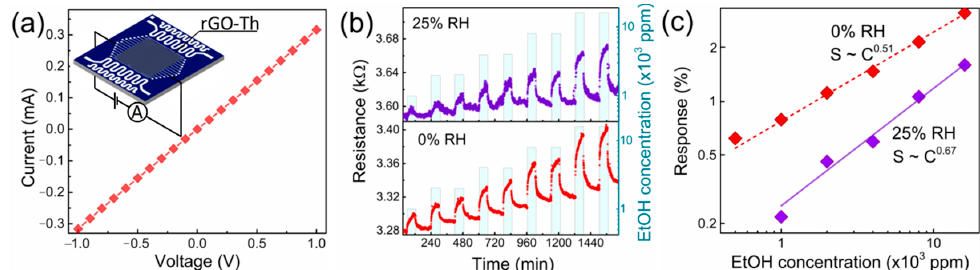
Figure 6. The chemiresistive performance of rGO–Th film. ( a ) I–V curve taken at both dc electric field directions under dry air conditions; the insert shows the measuring electrical circuit. Insert—a schematic model of the measured gas-sensor chip. ( b ) The resistance transient recorded under exposure to ethanol vapors of varied concentration C in range of 500–16,000 ppm when mixed with dry air (upper curve) and humid air (25% rel. humidity, bottom curve). ( c ) The dependence of chemiresistive response on the ethanol concentration in dry and humid air background. The measurements are taken at 40 ◦ C to avoid environment temperature v